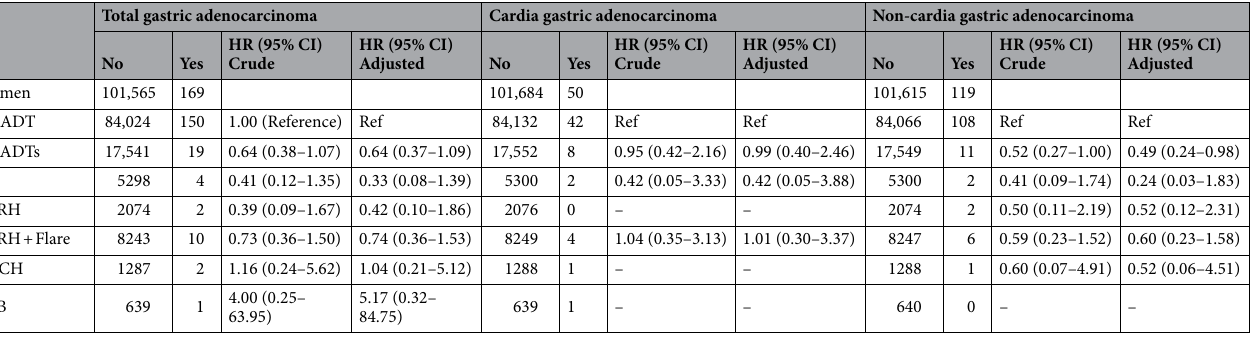
Table 3. Multivariable analysis of hazard ratio (HR) with 95% confidence interval (CI) of gastric adenocarcinoma according to exposure to androgen deprivation therapy (ADT). Multivariable Cox proportional hazard model including marital status (not married, married, separated and widower) and educational level; low (less than 10 years), intermediate (10–12 years) and high educational level (> 12 years). AA anti-androgens, GnRH gonadotropin releasing hormone, GnRH + Flare gonadotropin releasing hormone + flare protection with AA for a limited time (usually a month), ORCH orchiectomy, TAB total androgen